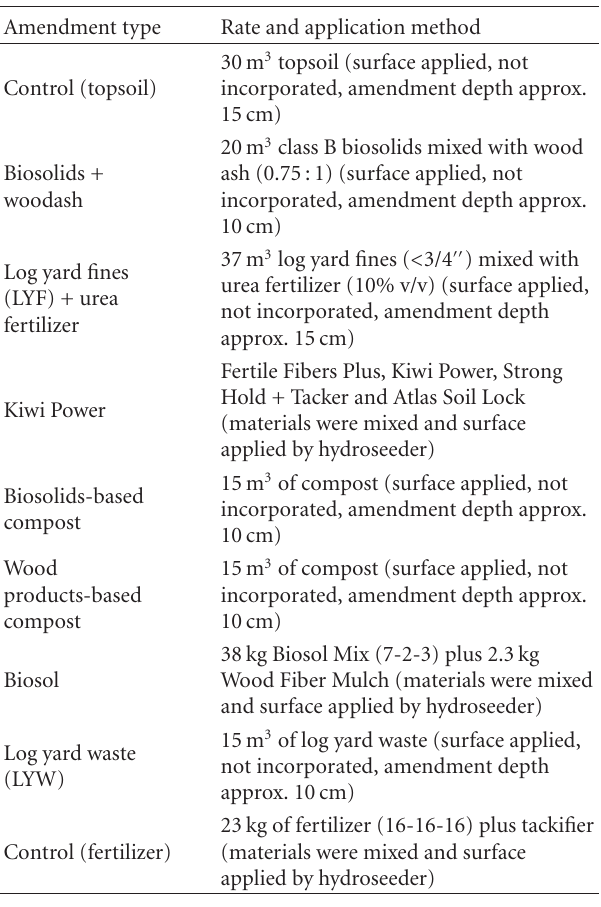
Table 1: Amendment type, application rates, and application meth-